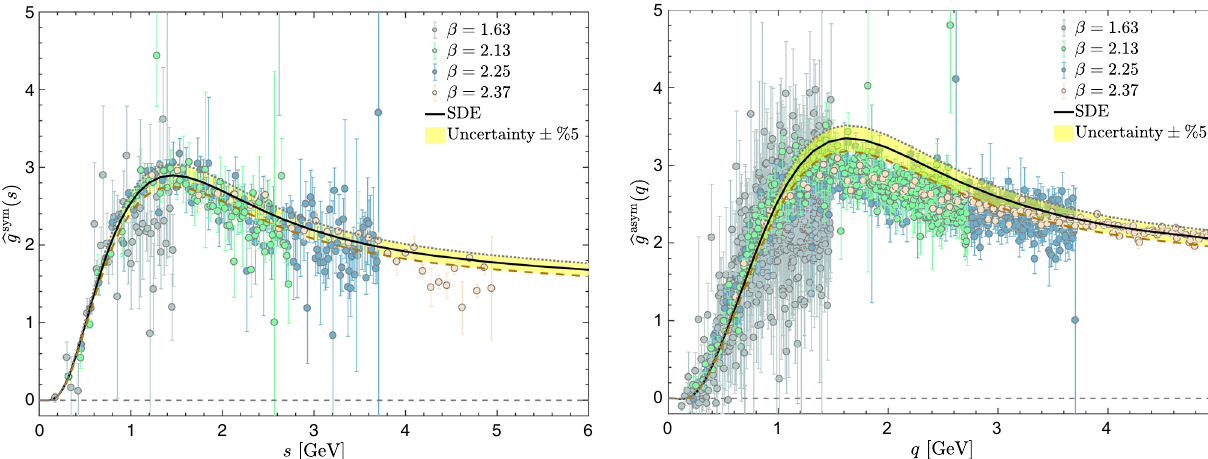
of g at μ =4.3 GeV has an uncertainty of ± 5%, with central val- ues g sym (μ 2 ) = 1 . 86 [ α sym (μ 2 ) = 0 . 27]. Right panel: The same for the asymmetric effective coupling, (cid:22) g asym ( q 2 ) , with a central value